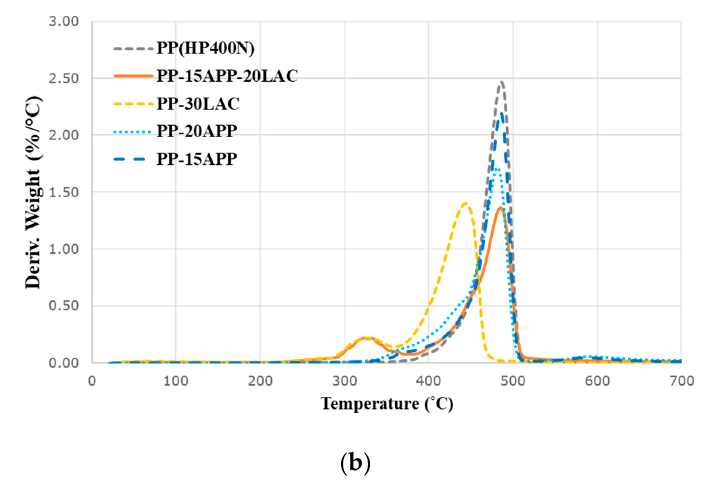
Figure 5. ( a ) Thermogravimetric and ( b ) derivative thermogravimetric curves of neat PP, PP–LAC, and PP–LAC–APP samples in nitrogen.